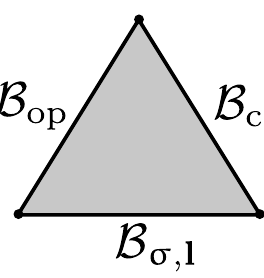
Figure 11 . A Liouville conformal block can be represented by a brane